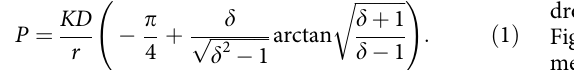
droplet–droplet centres expressed in a dimensionless form using d ¼ d c /2 r (Supplementary Note 2): KD P ¼ r